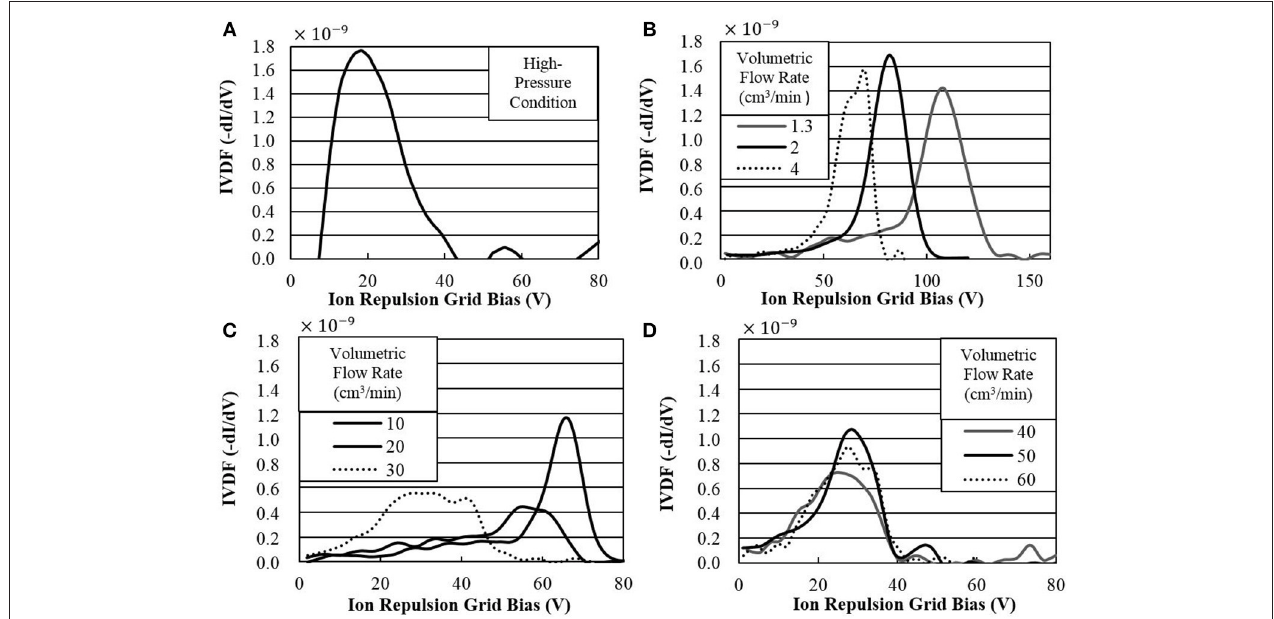
FIGURE 3 | IVDFs (uncorrected) measured at the exit plane for (A) “High-Pressure” condition and (B–D) “Low-Pressure” condition.